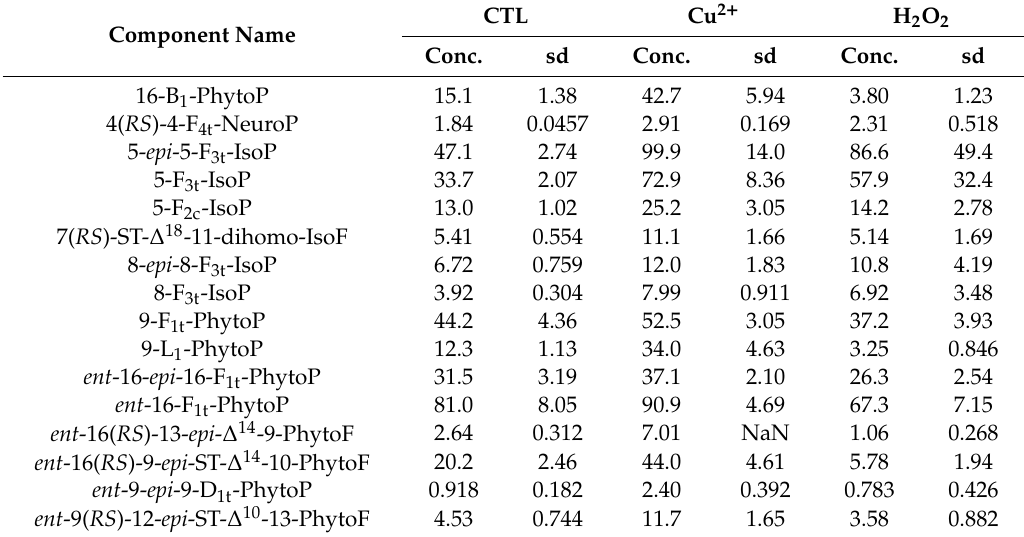
Table 5. Quantification of NEO-PUFAs in P. tricornutum incubated under control, copper or H 2 O 2 stress conditions. Data are mean ± sd (n = 3) expressed as ng / g dry weight. NaN stands for Not a Number, because they are impossible values.